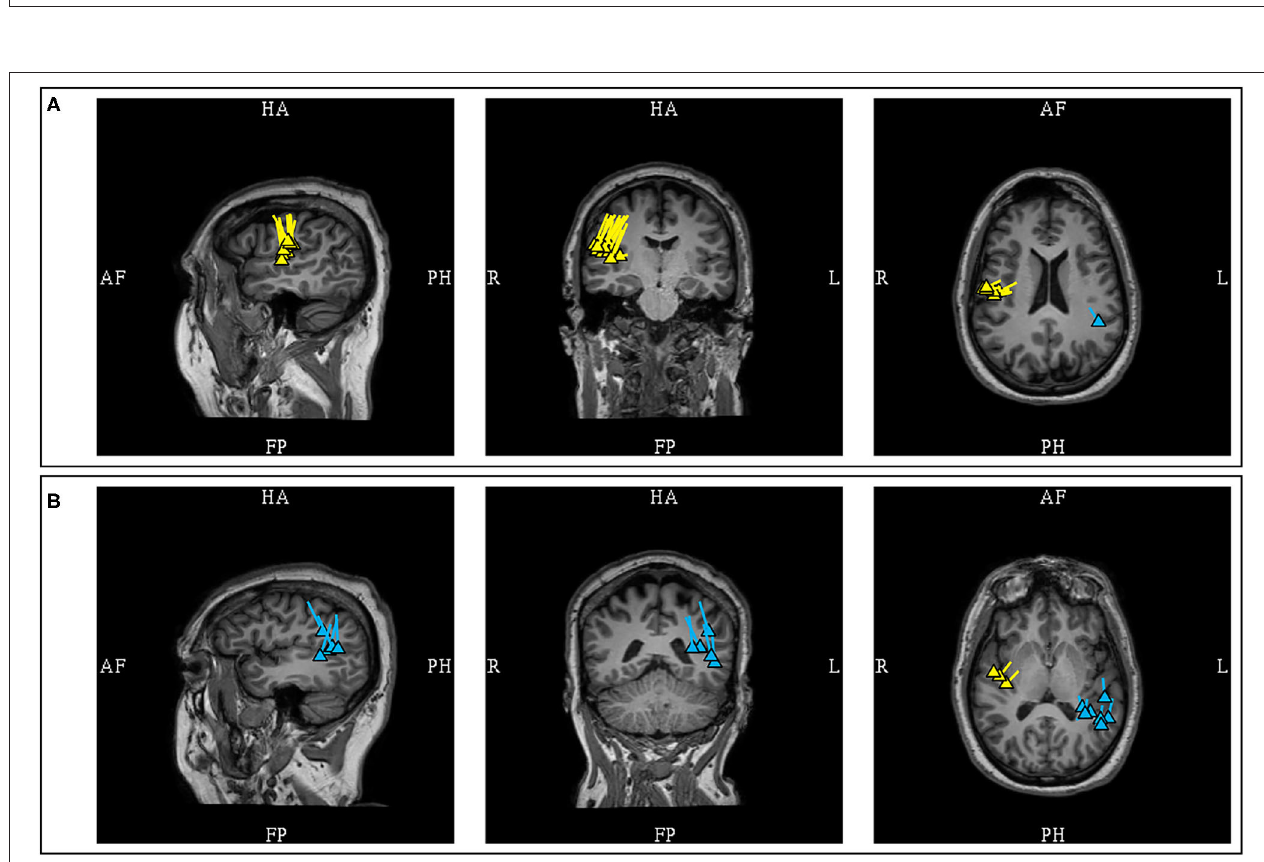
FIGURE 14 | MEG-MRI coregistration summary demonstrating supra-Sylvian dipoles in the same patient. (A) The pathologic right mid-supra-Sylvian cluster (yellow) is tight and uniformed, and correlated with a small right fronto-opercular MRI lesion upon imaging repeated review. (B) Benign left posterior supra-Sylvian cluster (blue) is loose with fairly uniform orientation. This is a cluster of benign normal variant that has neither EEG correlation nor clinical suggestions, and was not included in the clinical summary report.